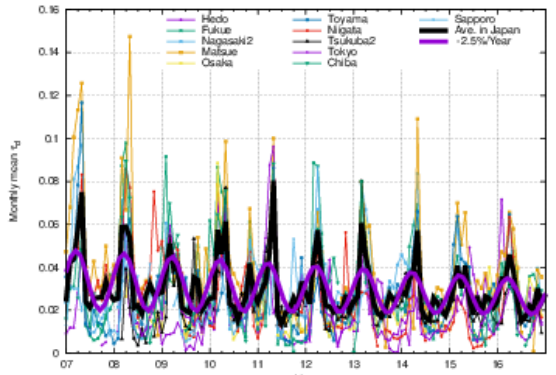
Fig.3 Monthly variations of Tau_d since 2008 observed by independent lidars in Japan (thin lines), average in Japan (thick line) and fitted curve to average (solid purple). Reproduced from